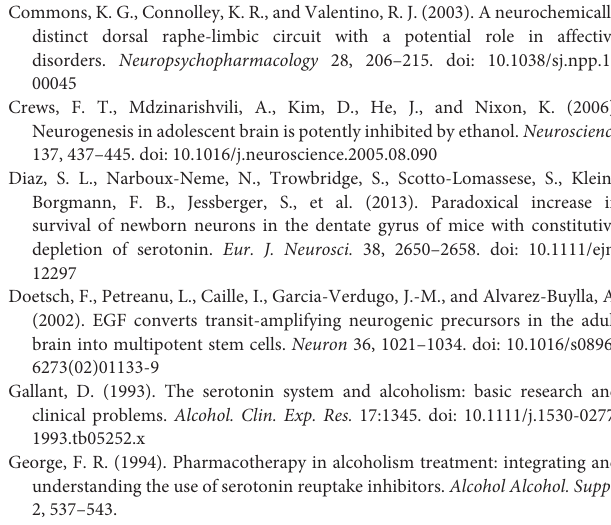
FIGURE S1 | (A) Stability of ethanol intake along the last 6-weeks of DID, during behavioral and neurogenesis testing at selected time-points, at week 12, 13, 15 and 18. No significant changes were observed in each treatment group (two-way ANOVA with repeated measures and Bonferroni’s multiple comparison. Effect of time: F (3,42) = 1.823, P = 0.1577). Effect of treatment: F (1,14) = 0.3692, p = 0.5532). (B) Volume of granular cell layer samples for each group in the